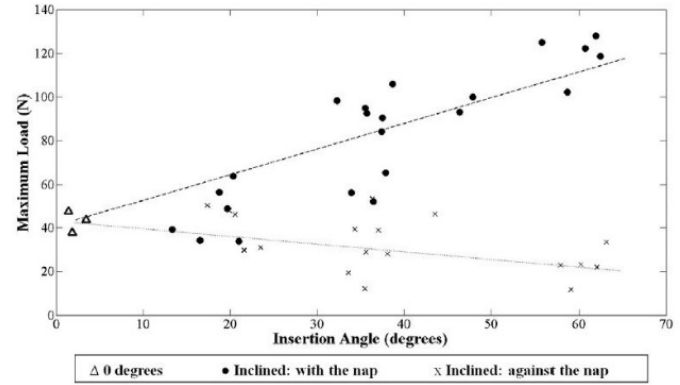
Figure 32. E ff ect of z-Pin o ff set angle on maximum load Figure 32. Effect of z-Pin offset angle on maximum load [17].